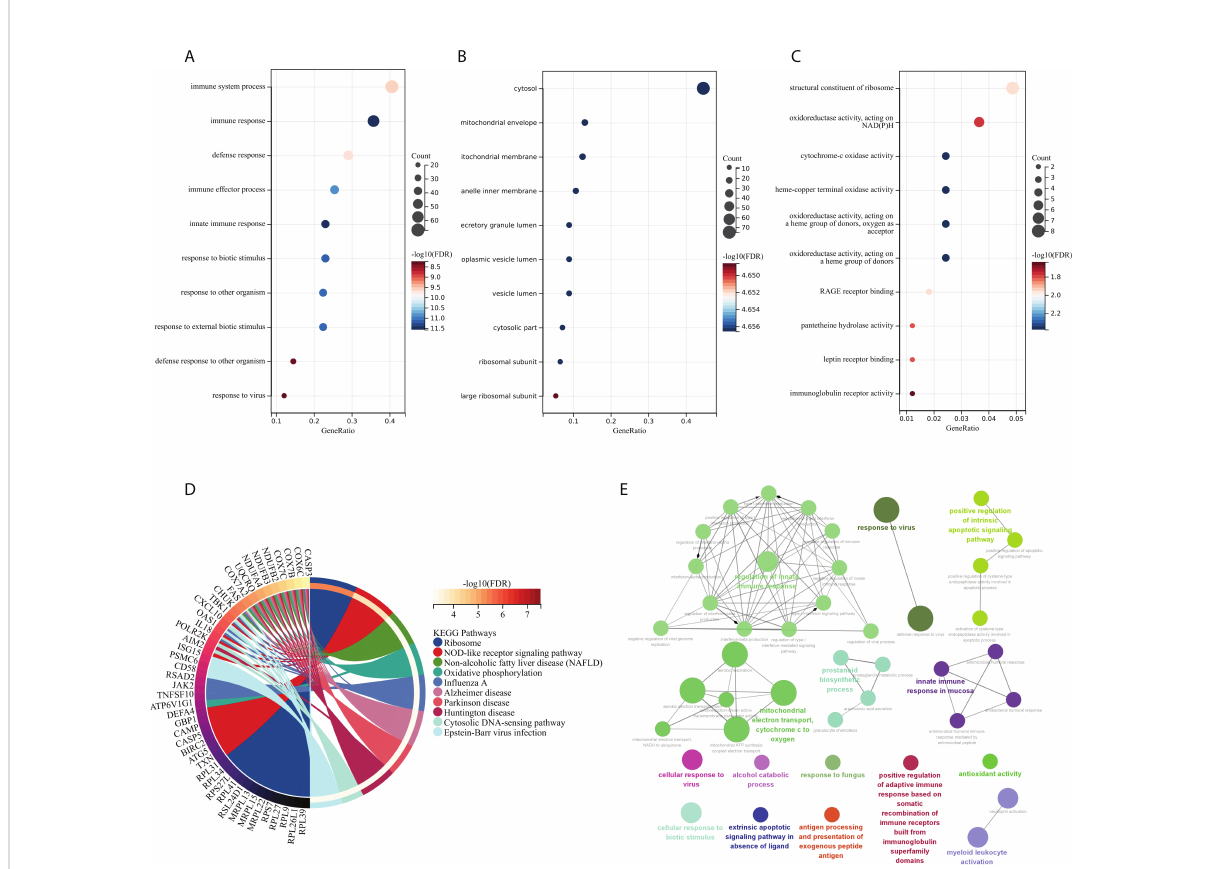
FIGURE 5 Functional enrichment analysis: GO, KEGG, and ClueGO analysis of DEGs. (A) BP gene enrichment of DEGs. (B) CC gene enrichment of DEGs. (C) MF gene enrichment of DEGs. (D) Analysis of DEGs using KEGG. (E) Analysis of DEGs using ClueGO.